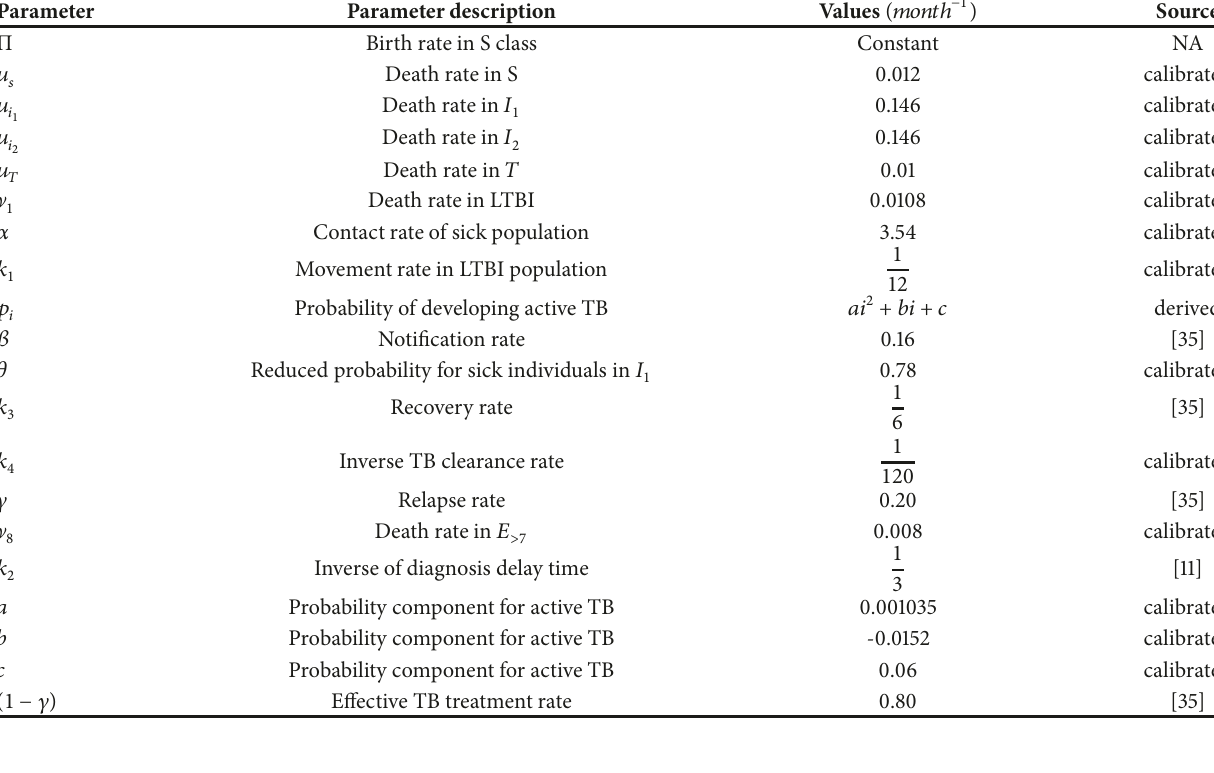
Table 1: Summary description of parameters of the model fitted to Nigeria data (2000-2015).